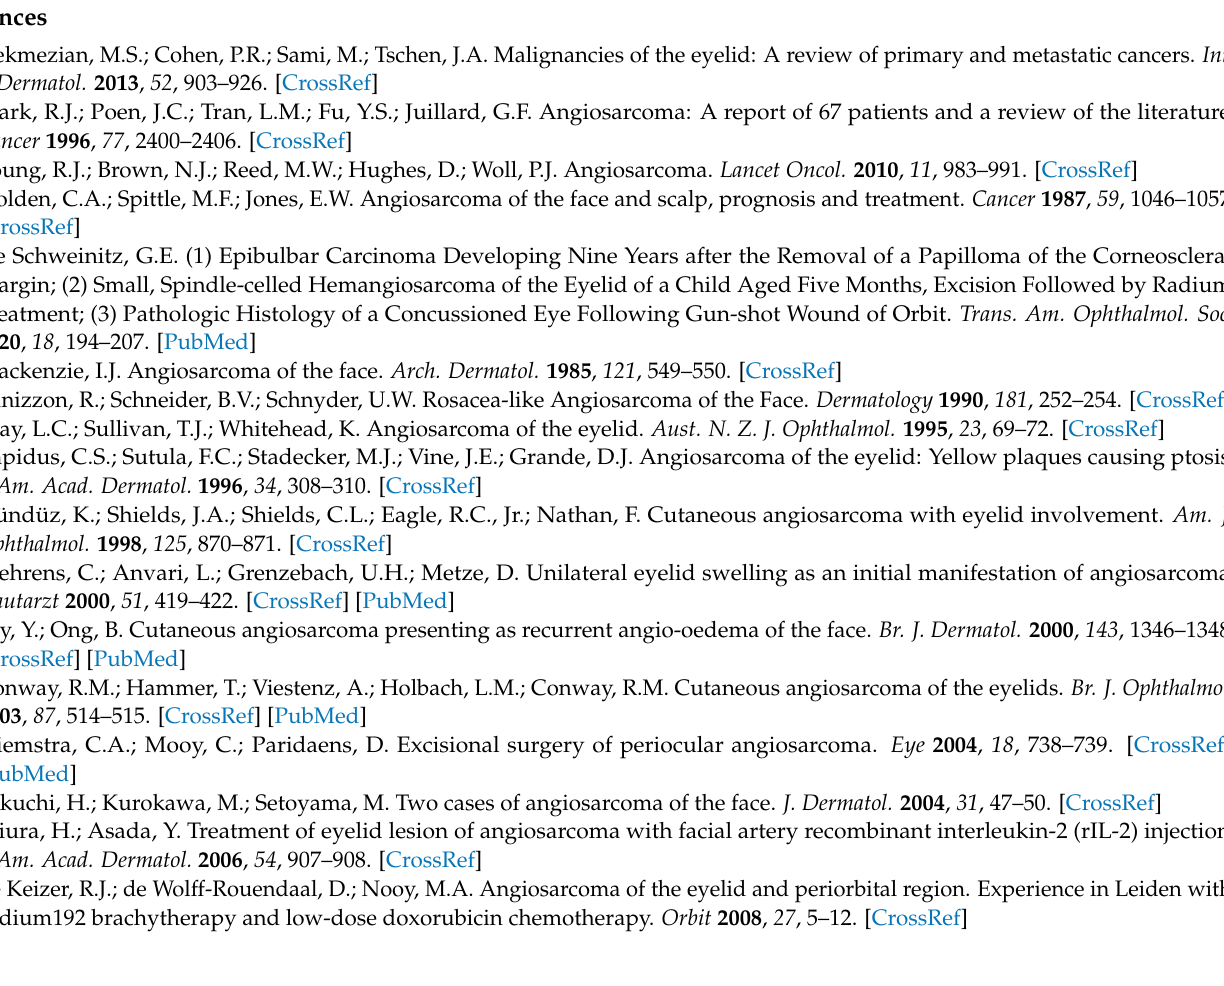
Table S2: Critical appraisal checklist of case reports included in the analysis